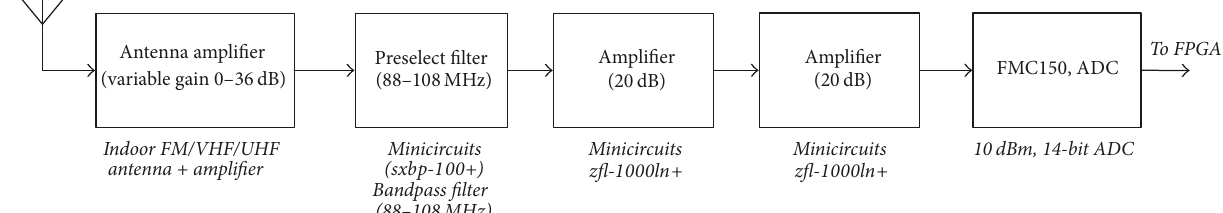
Figure 23: A block diagram of the analog RF